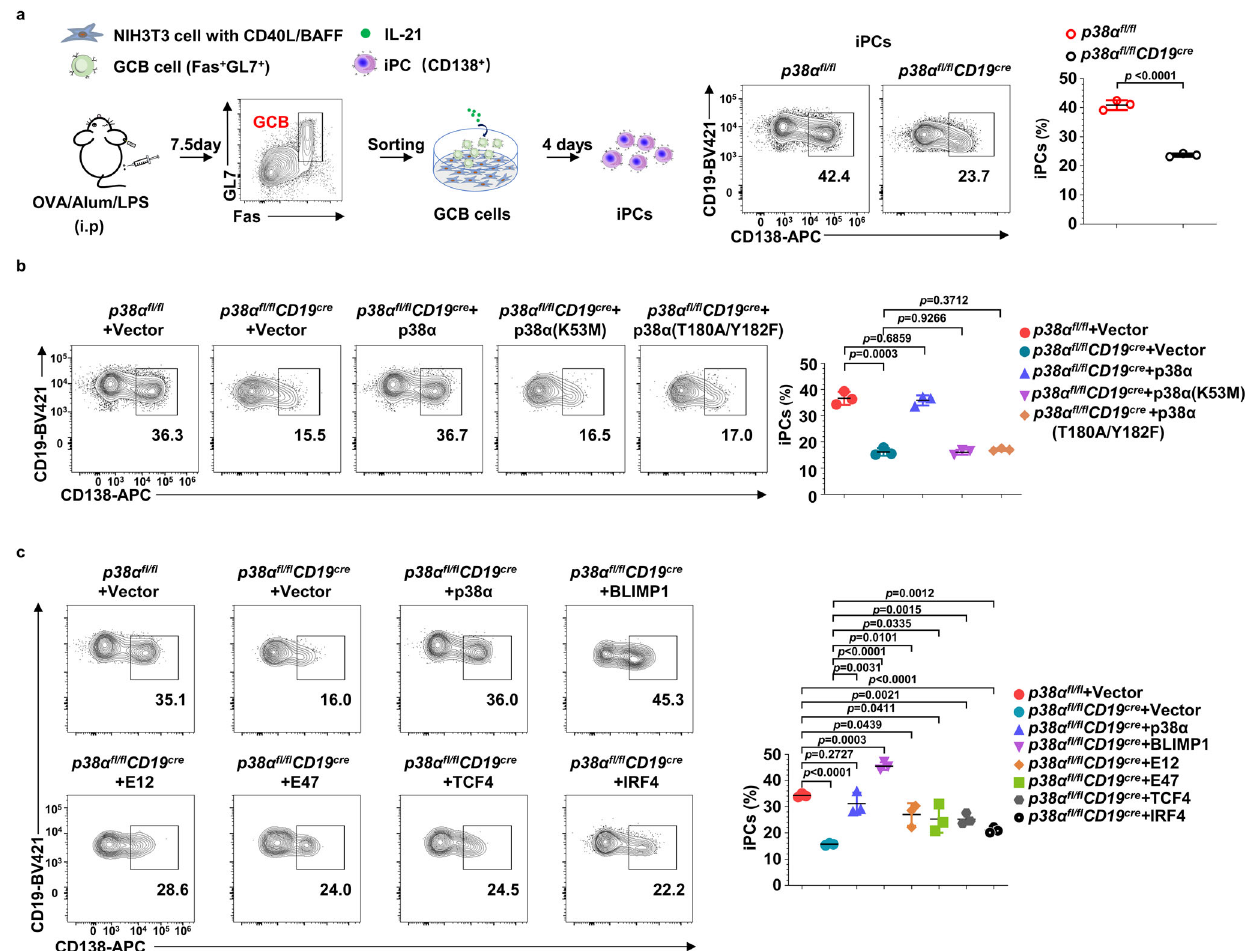
Fig. 8 | The p38 α -BLIMP1 axis controls PC generation differentiated from invivogeneratedGCBcells.a SortGCBcells(CD3 − B220 + Fas + GL7 + )fromthespleen of OVA/Alum/LPS immunized mice ( n =10 per group) at day 7.5 were mixed and cultured on IL-21 feeder cells, and iPCs differentiated from p38 α KO and WT GCB cells were analyzed at day 4. b Sorted p38 α KO GCB cells from the spleen of OVA/ Alum/LPS immunized mice ( n =10 per group) were mixed and cultured on IL-21 feeder cells and transduced with retroviruses encoding p38 α or p38 α kinase-dead mutants (K53M or T180A/Y182F) 1 day later. The percentage of iPCs in retrovirus-